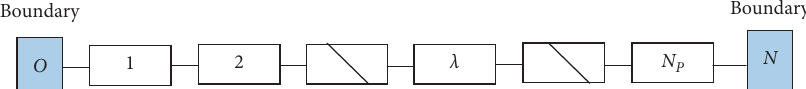
Figure 2: The monocoupled periodic structure of N